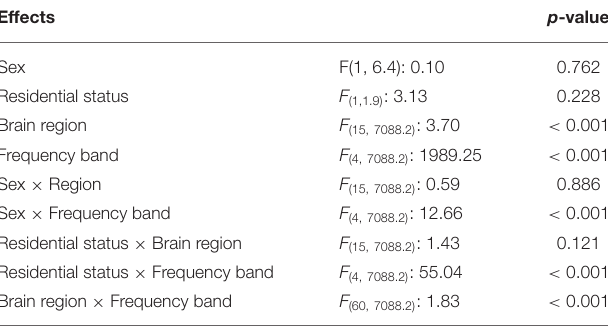
TABLE 5 | F-statistics and p -values from the linear mixed model of the effect of child’s sex, residential status, brain region, frequency band, and interactions thereof, on the observed coherence measures.